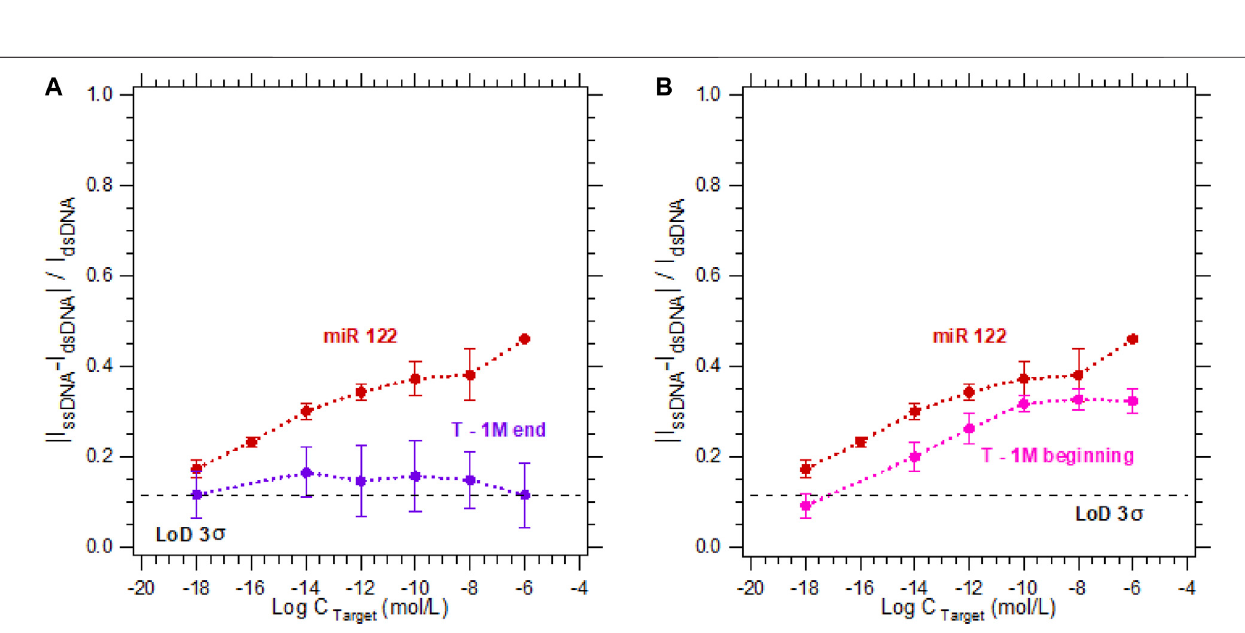
Frontiers in Chemistry |